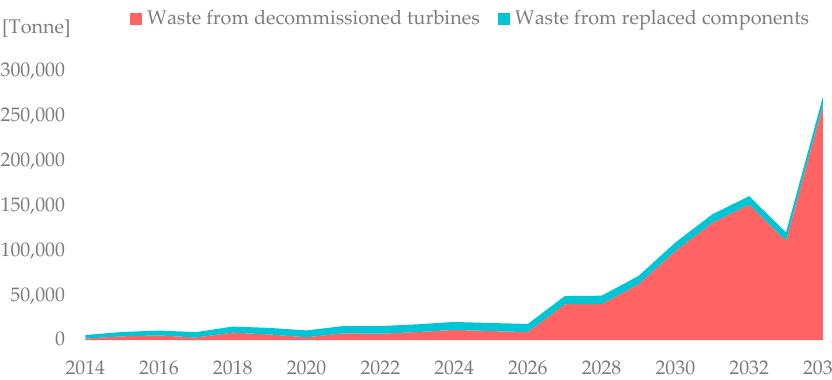
Figure 5. Estimated amount of waste material from Swedish wind turbines between 2014 and 2034. The combined mass of material from both replaced components (blue area) and decommissioned turbines (red area).